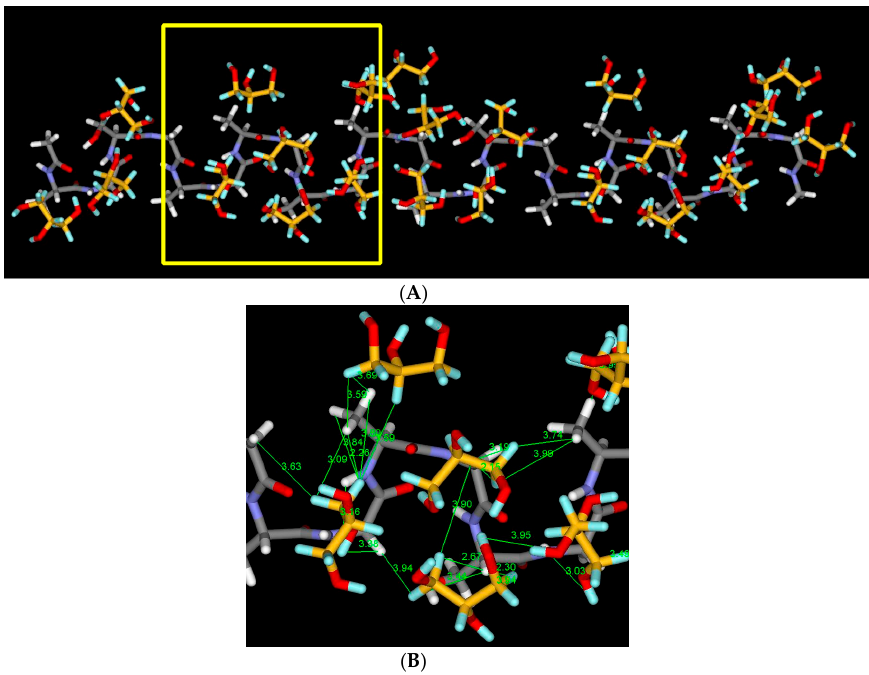
Figure 9. ( A ) A complex model of Glyc-SF model peptide, Acetyl-(Ala-Gly-Ala-Gly-Ser-Gly) 2 -NHCH 3 with Silk I* form after 500 ps of Molecular Dynamics (MD) simulation. Details of the calculation are described in Materials and Method. The model satisfies the observed 1 H– 1 H distance information. Four models including this model are shown in Figure S1; ( B ) the calculated distances between 1 H atoms in Glyc and 1 H atoms in SF in the area surrounded by square ( yellow ) in Figure 9A are shown as an example. All of the calculated 1 H atomic distances between Glyc (CH 2 ) and Ala H β , Glyc (CH 2 ) and Gly H α ① , Glyc (CH 2 ) and Ser H α , Glyc (OH) and Ser H α , Glyc (OH) and AlaHN, and Glyc (OH) and Gly H N are within 4 Å which satisfies the corresponding observed distances in Figure 8.